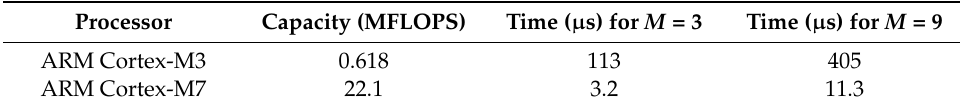
Table 3. Computational time per bit decision by SIC